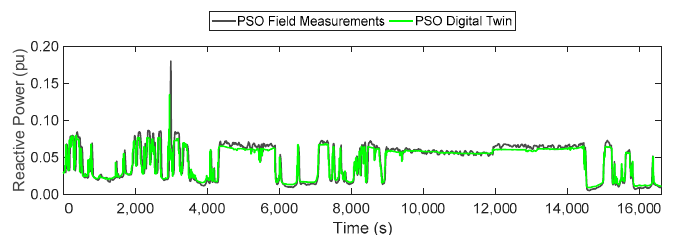
Figure 14. Comparison Between the Digital Twin and the Field Demonstration Active Powers.